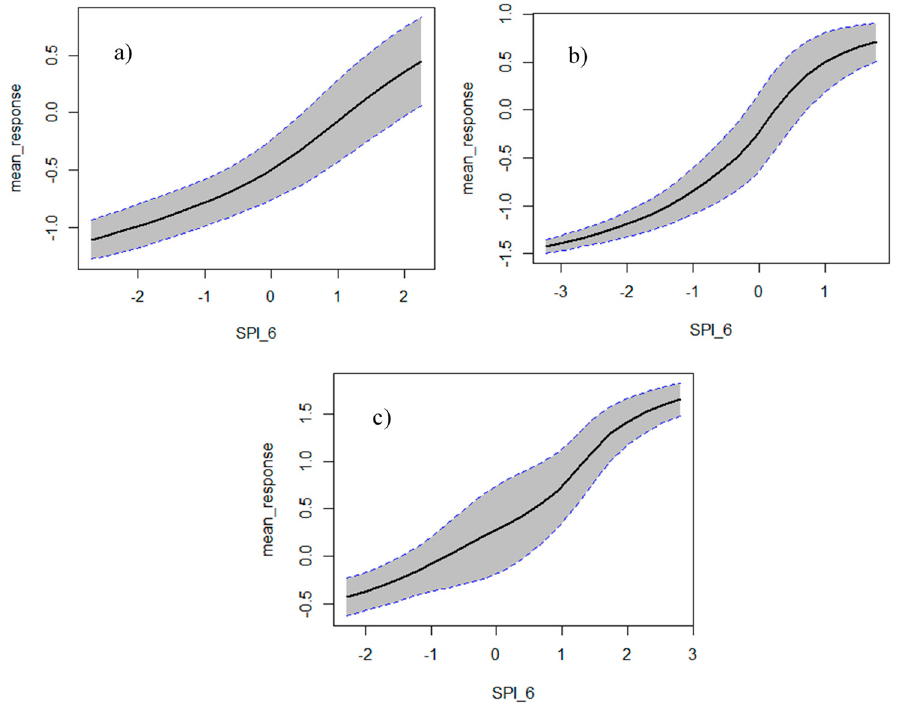
Figure 14. The marginal effect of SPI-6 on SMDI at three phenology stages: ( a ) SOS, ( b ) LOS, and ( c ) EOS (X-axis represents SPI value and Y-axis represents SMDI value).